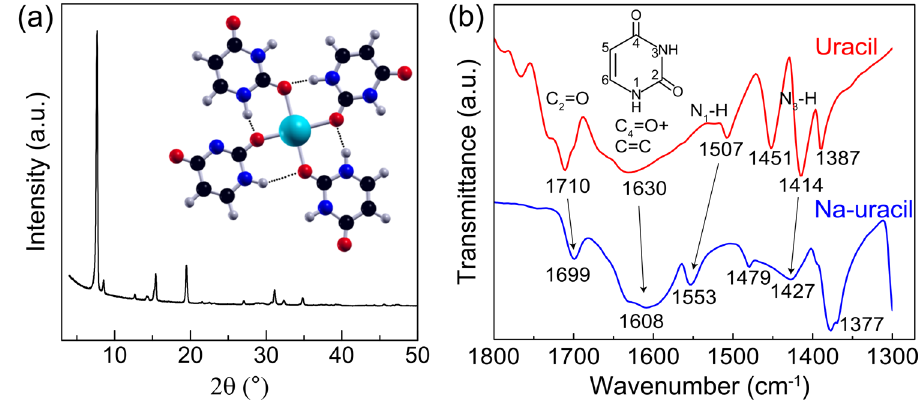
Figure 1. GIXRD pattern ( a ) and FTIR spectrum ( b ) recorded for our Na-uracil thin films (in the latter case uracil spectrum is also shown for reference); the tetrametric structure and the numbering of the atoms in uracil molecule are shown in the insets,